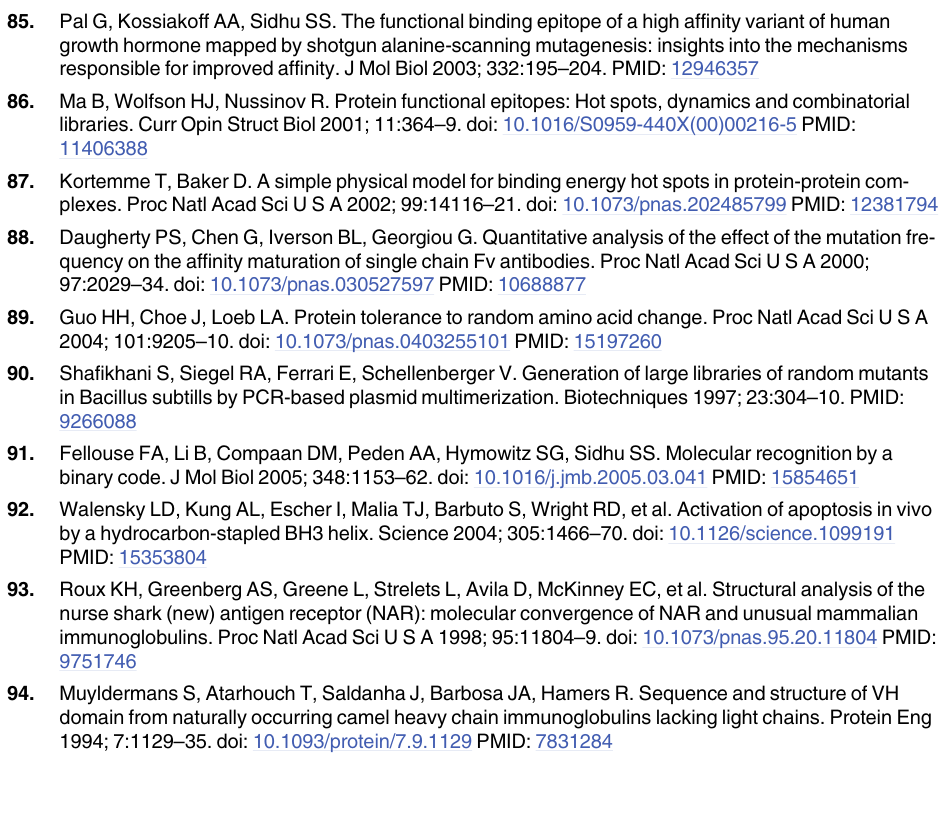
PLOS ONE | DOI:10.1371/journal.pone.0138956 September 18,